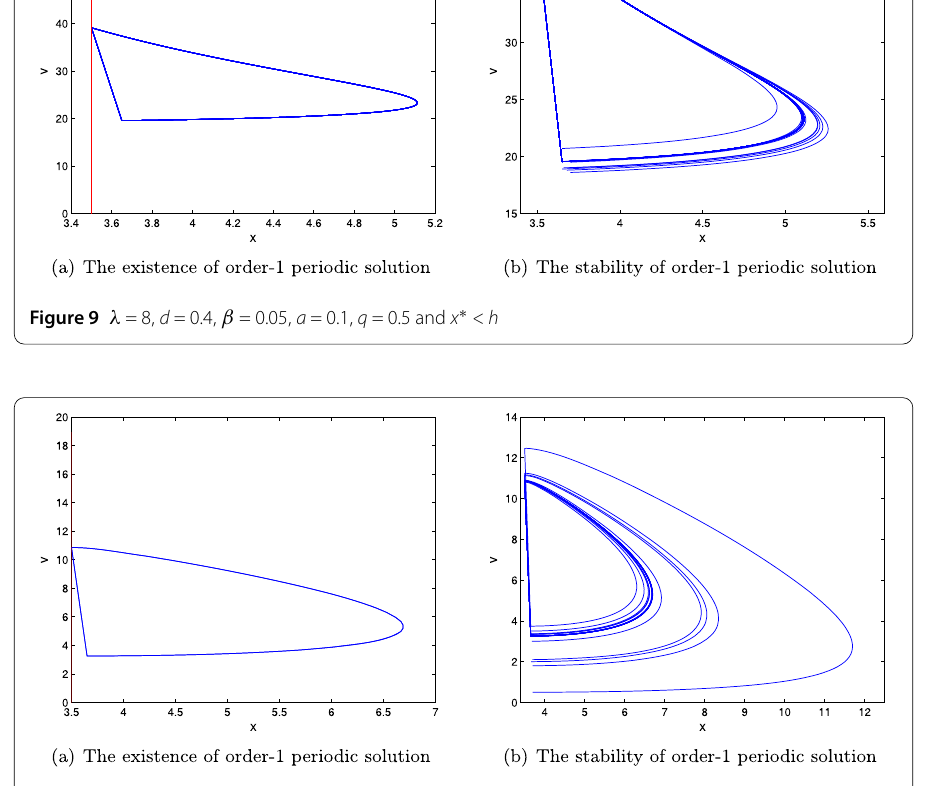
Figure 10 λ = 0.6, d = 0.01, β = 0.015, a = 0.053, q = 0.7 and h < x ∗ < ¯